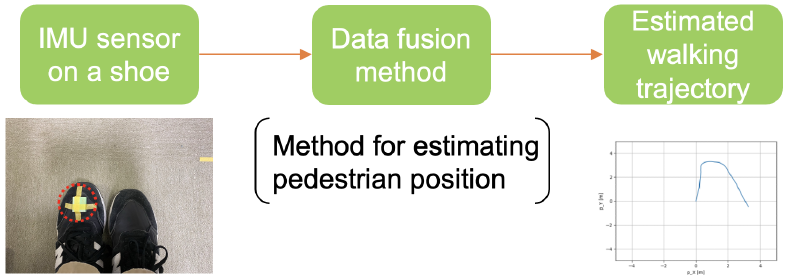
Figure 1. Application